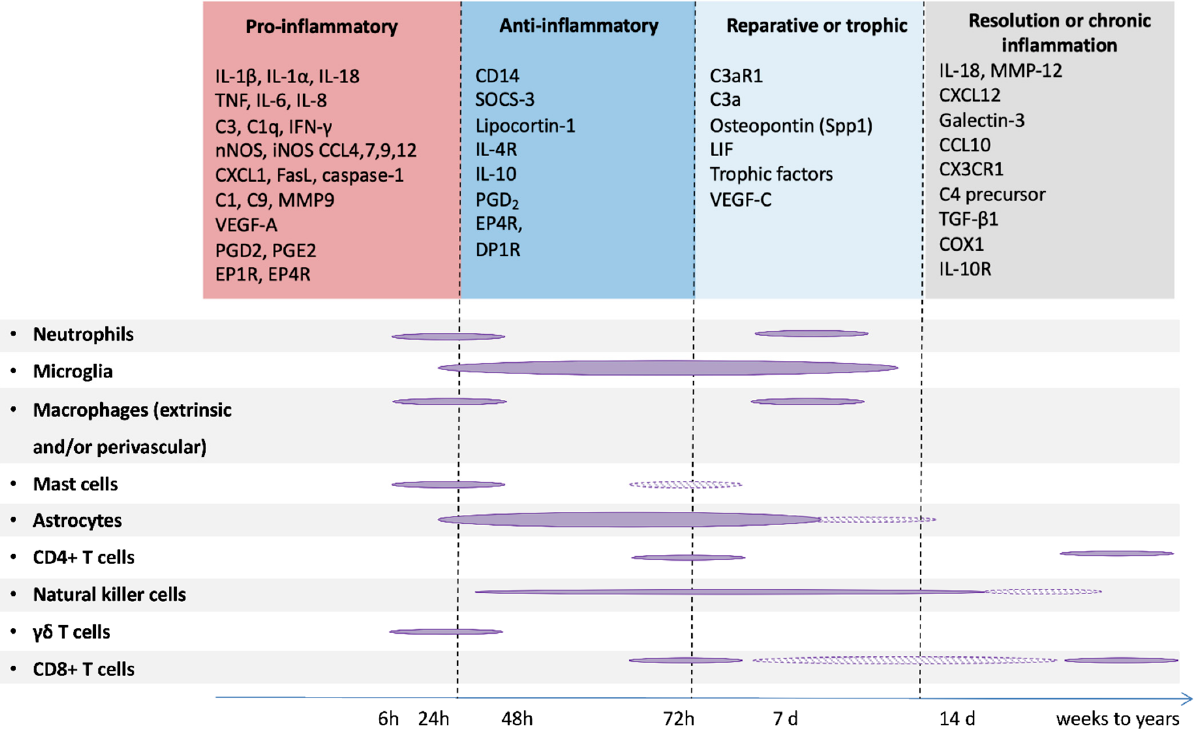
Figure 4. Schematic representation of the immune reaction following a hypoxic-ischemic brain insult in newborn rodents. The hypoxic-ischemic insult triggers a proinflammatory response followed by anti-inflammatory and reparative phases. These events result either in resolution of inflammation or in chronic inflammation. Filled clouds correspond to demonstrated events and shaded clouds correspond to potential events. Adapted from [72] .